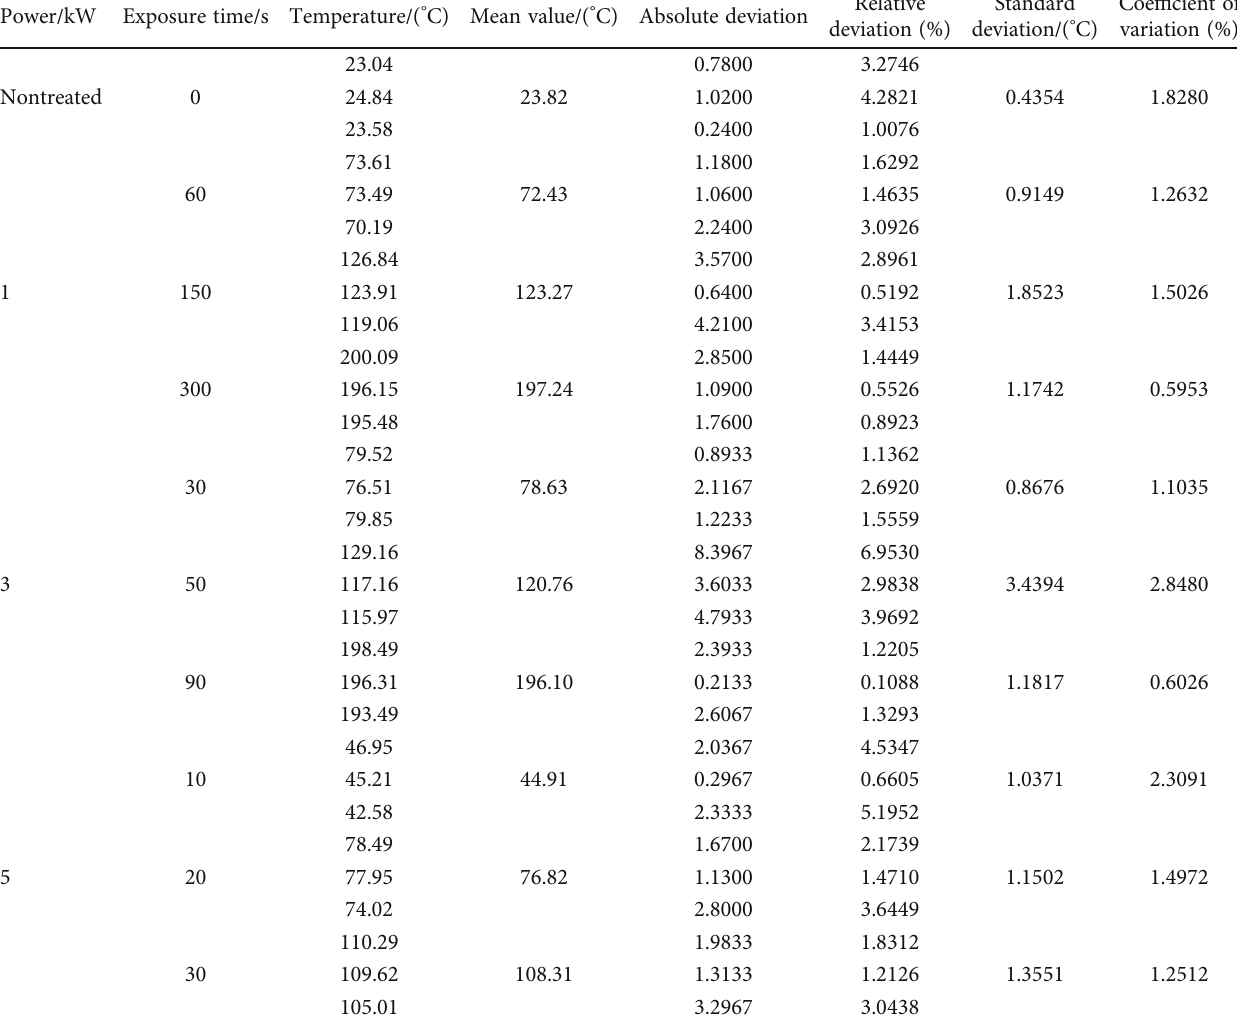
Table 3: Testing results of surface temperature induced by microwave irradiation.